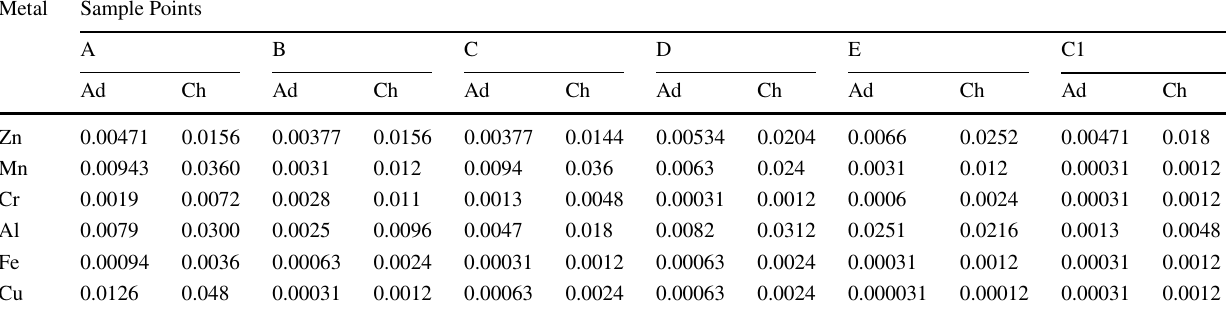
Table 6 The Chronic Daily Intake of Metal contaminants in the study area